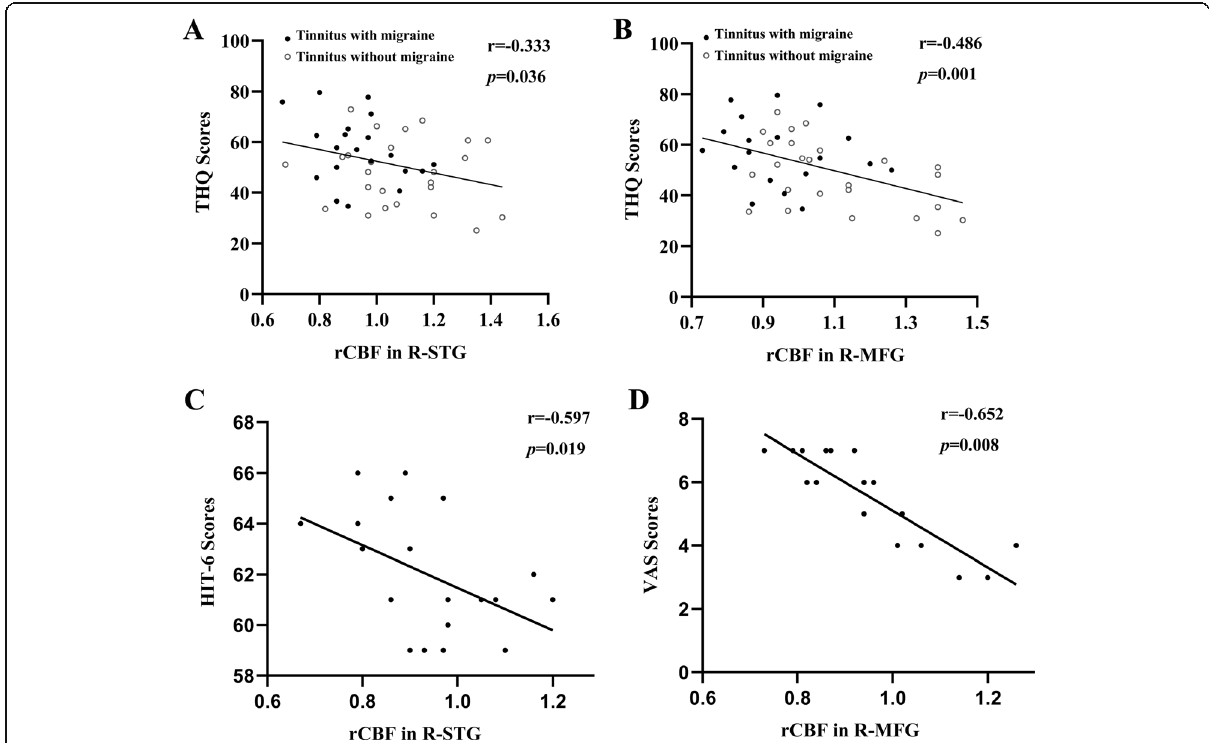
Fig. 4 The significant correlations between the rCBF changes and the clinical data. ( A ) rCBF in the right STG was negatively associated with THQ scores (r=-0.333, p = 0.036) in tinnitus patients with and without migraine; ( B ) rCBF in the right MFG was negatively associated with THQ scores (r=-0.486, p = 0.001) in tinnitus patients with and without migraine; ( C ) rCBF in the right STG was inversely correlated with the HIT-6 scores (r=- 0.597, p = 0.019) in tinnitus patients with migraine; ( D ) rCBF in the right MFG was inversely correlated with the VAS scores (r=-0.652, p = 0.008) in tinnitus patients with